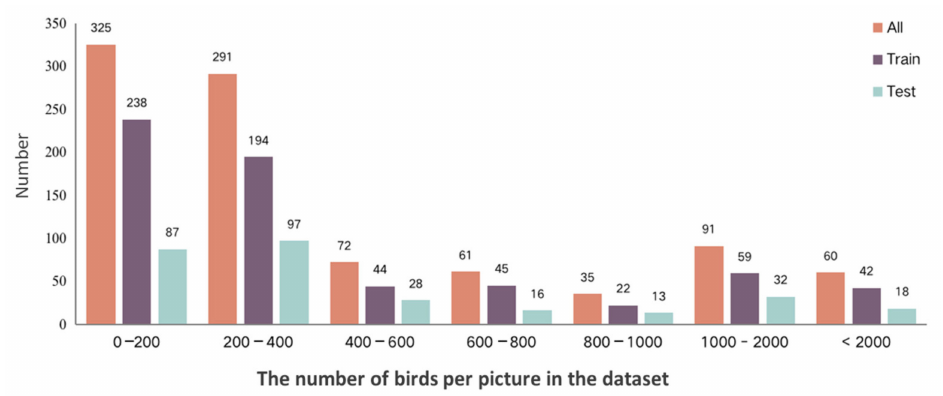
Figure 5. The distribution of image resolution and corresponding image quantity in the bird dataset.